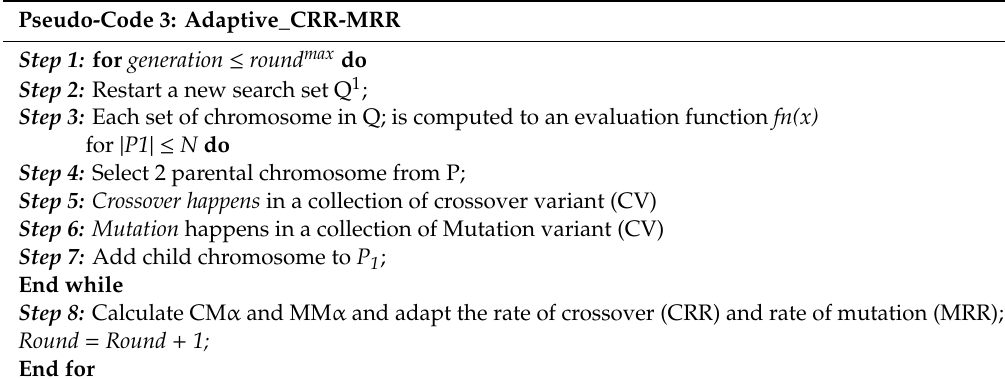
Table 6. Pseudo-code 3 for Adaptive_CRR-MRR.